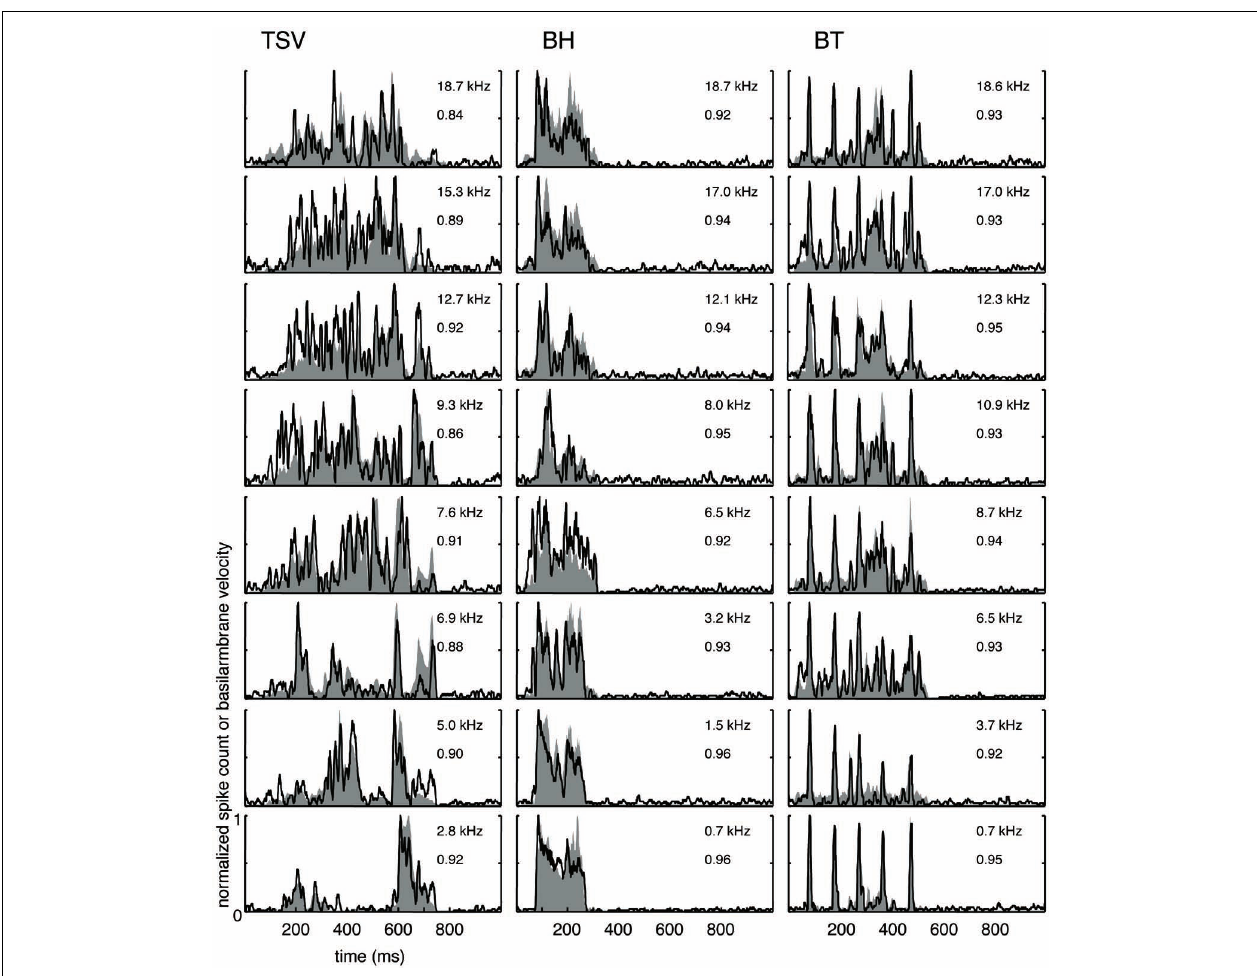
FIGURE 4 | Maximum correlations. Examples with the highest correlation values across our data set for different frequency regions are shown for the three vocalizations. Black lines correspond to the PSTHs and gray shaded